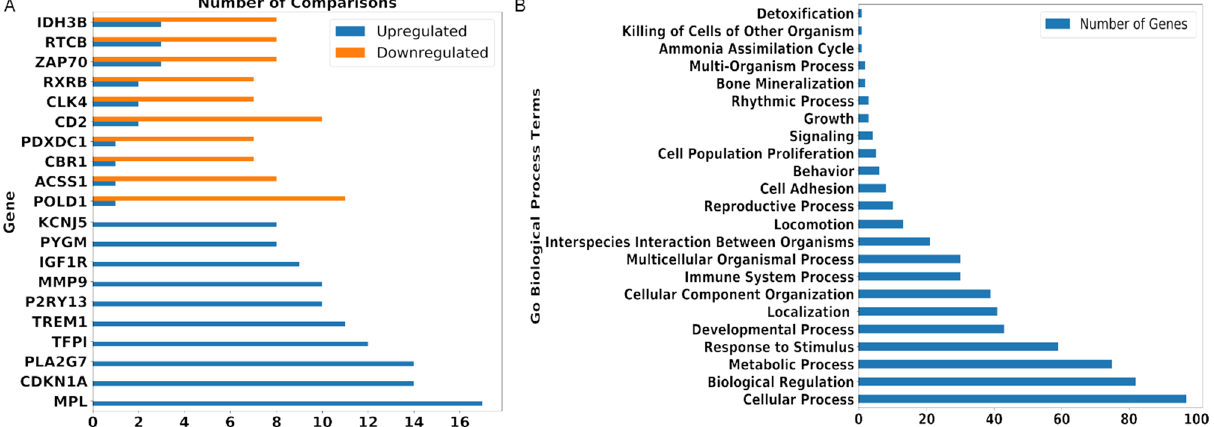
Figure 4. ( A ) Hub genes found in multiple networks with consistent regulation depicted with the count of samples upregulated/downregulated. ( B ) Count of genes in GO Biological processes amongst 101 consistently differentially regulated